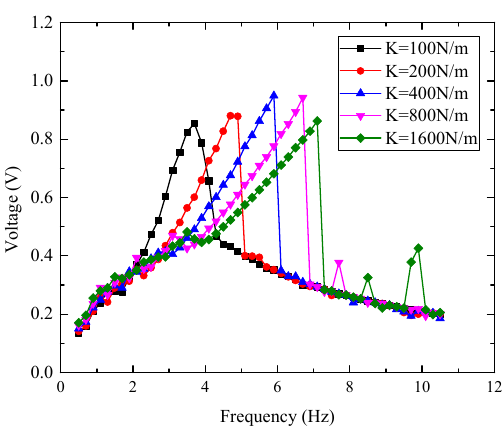
Figure 6. Effects of spring stiffness on RMS voltages under the base excitation of 0.2 g .